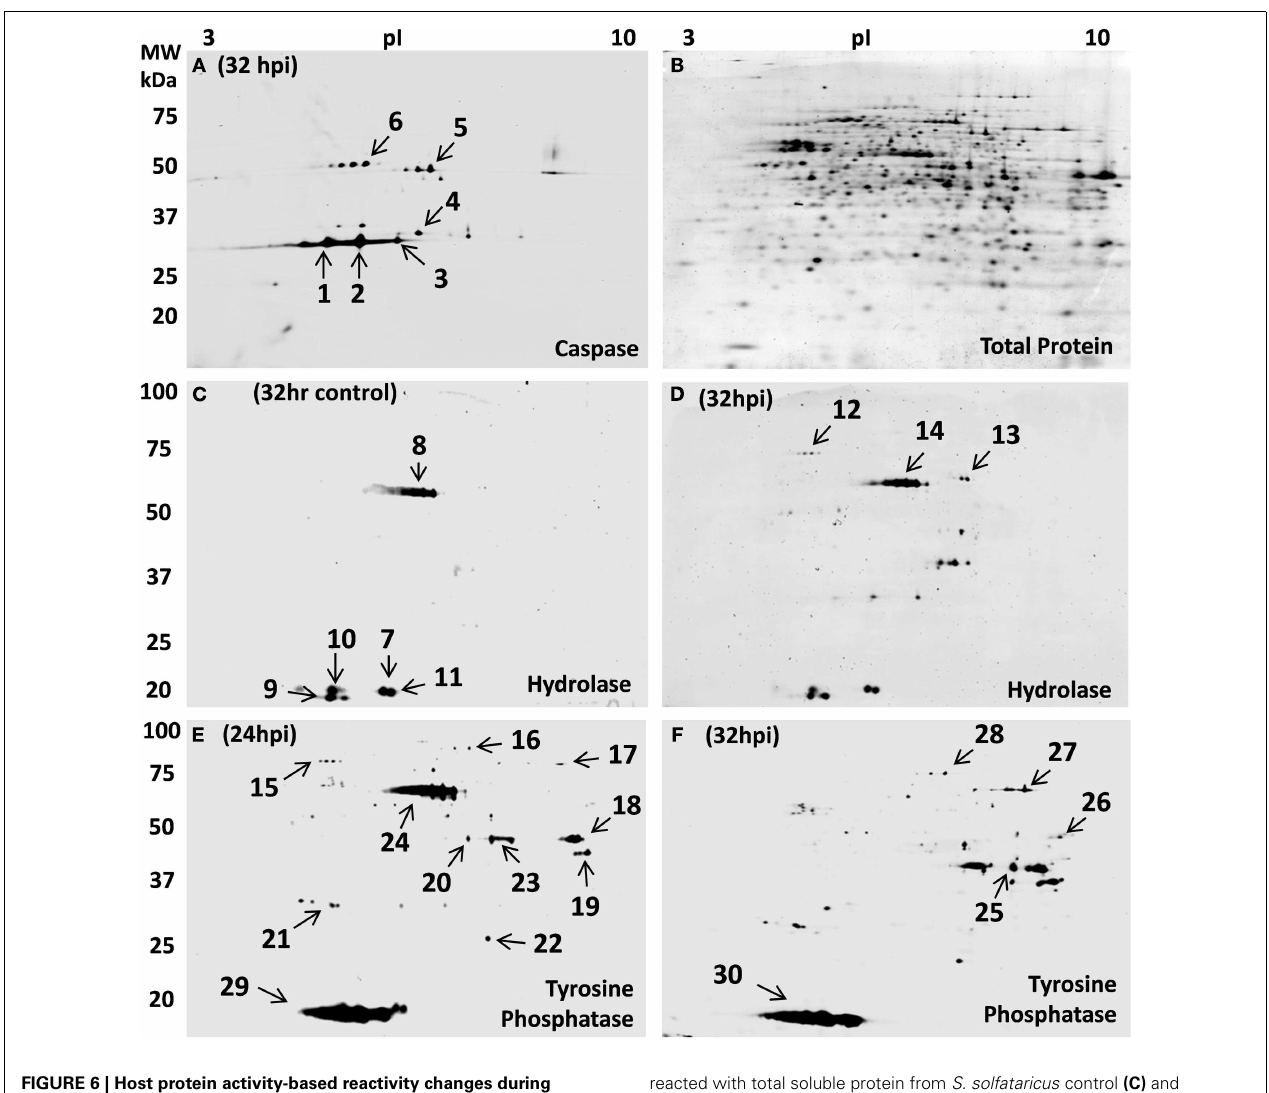
FIGURE 6 | Host protein activity-based reactivity changes during STIV infection. (A) Novel zwitterionic acyloxymethyl ketone probe (ZG-AOMK) for caspase as described in the text, was reacted with total soluble protein from 32h infected S. solfataricus . Approximately 27 protein spots were labeled with the caspase specific probe. (B) Subsequent staining for total protein, using SyproRuby, showed ∼ 800 spots. Zwitterionic fluorophosphonate (ZG-FP) for Serine hydrolase was